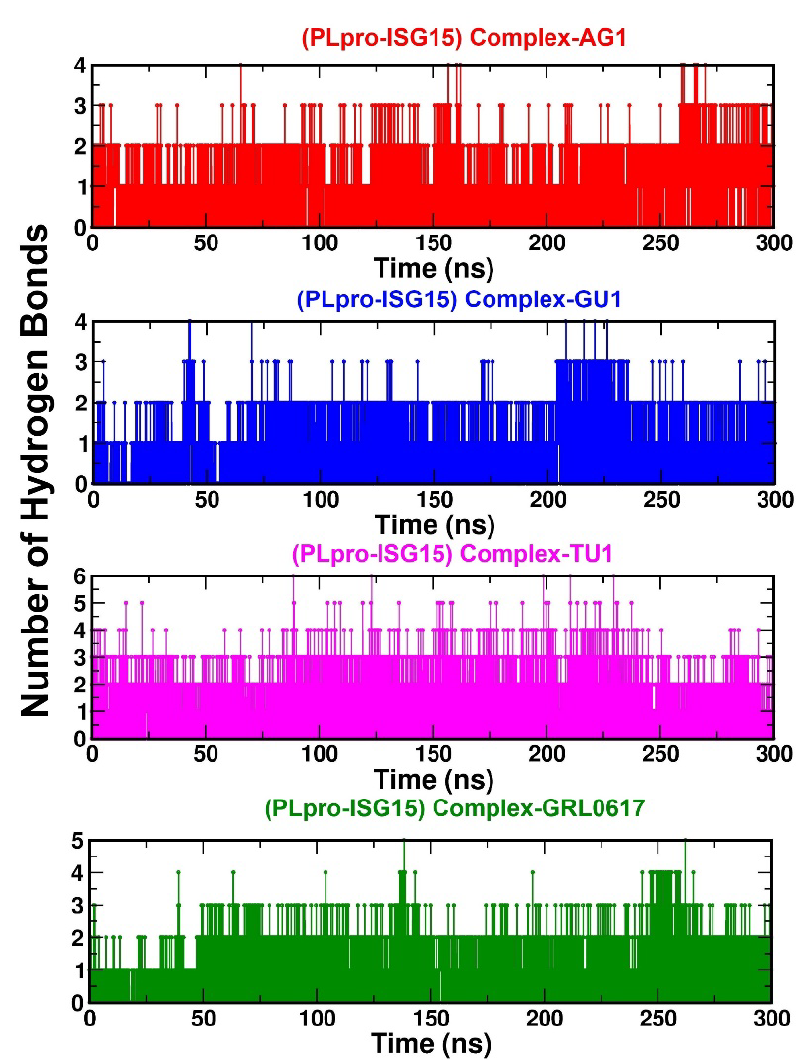
Figure 4. Number of hydrogen bonds formed between the phytochemicals (AG1 (red) or GU1 (blue)